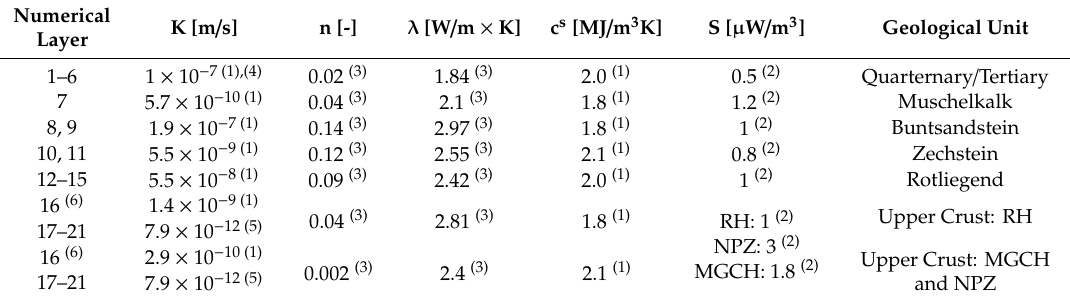
Table 2. Physical properties used for all simulations together with a schematic representation of the six geological units. Values were taken from the following literature: (1) Bär et al. [9], (2) Freymark et al. [8], (3) Rühaak et al. [23], (4) Herrmann [18], (5) Clauser et al. [48], (6) Stober and Bucher [49]. K = hydraulic conductivity, n = porosity, λ = thermal conductivity of the solid phase, cs = volumetric heat capacity of the solid, S = radiogenic heat production, RH = Rhenohercynian, NPZ = Northern Phyllite Zone, MGCH = Mid German Crystalline High.